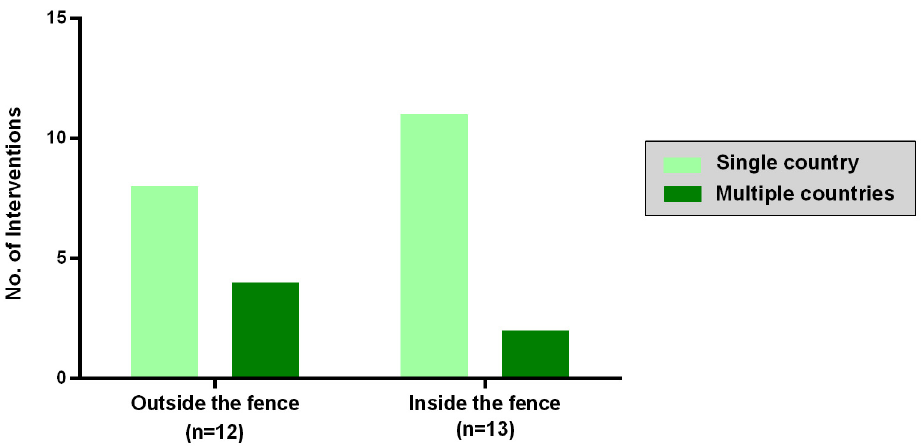
Figure 1. Scale of